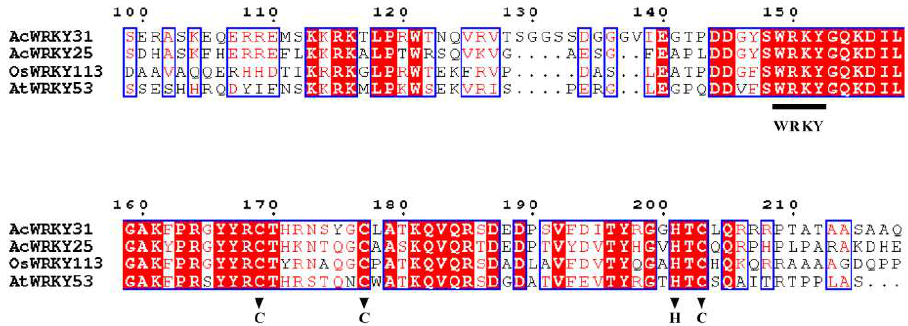
Figure 1. Multiple sequence alignments of AcWRKY31 and its ortholog proteins. The WRKY domain is indicated by the black line, and black triangles indicate the C2HC zinc-finger motif.